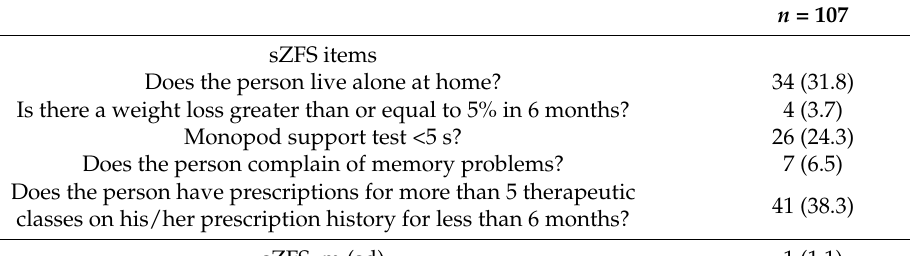
Table 4. Frailty measured by